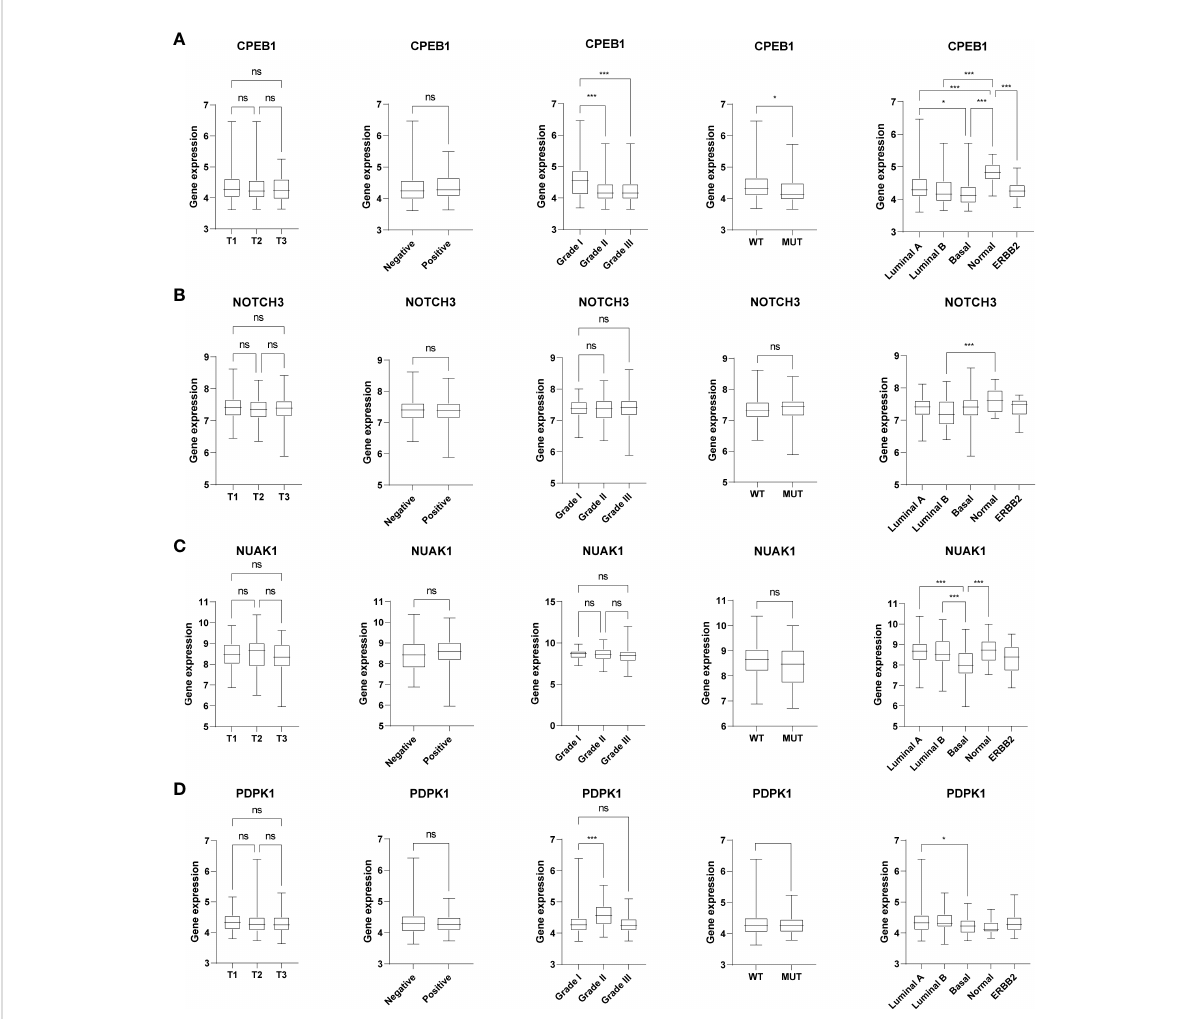
FIGURE 8 The relationships between the four senescence-related genes and clinical features. The box plots showed the correlations between CPEB1 (A) , NOTCH3 (B) , NUAK1 (C) , and PDPK1 (D) and tumor stage, ER status, tumor grade, P53 mutation, and molecular subtypes of BRCA. * P value < 0.05; *** P value <